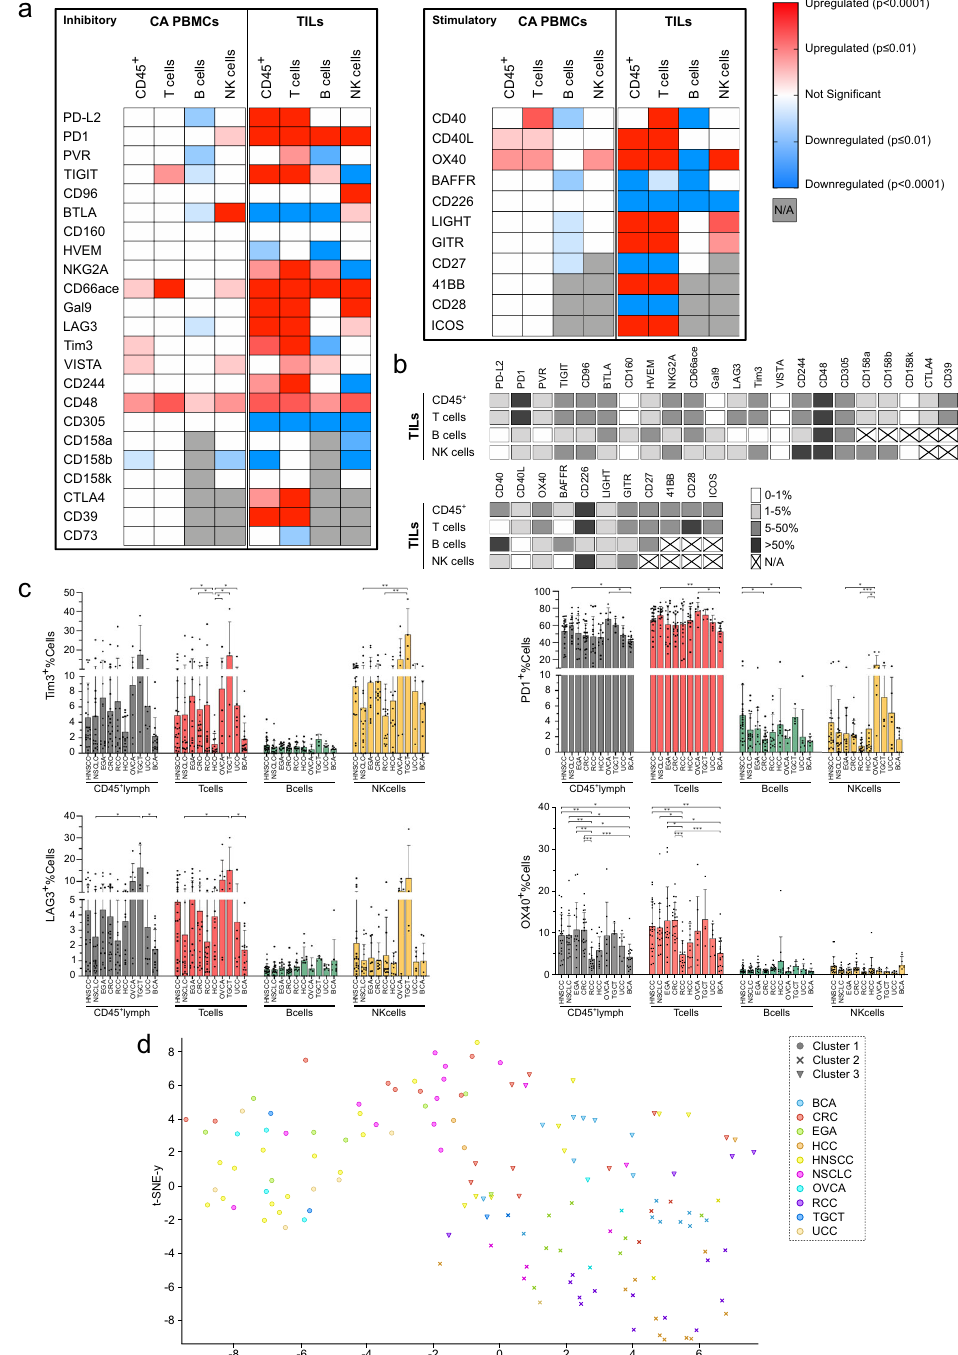
Fig. 2 Immune checkpoints on TILs are dysregulated with molecule and cancer-dependent differences. a Co-inhibitory and co-stimulatory molecule expression was analyzed by fl ow cytometry. The gating strategy is described in Supplementary Fig. 12. Signi fi cant up-/ downregulation of co-inhibitory and co-stimulatory immune-checkpoint molecule expression on CD45 + ( n = 137), T cells ( n = 137), B cells ( n = 120) and NK cells ( n = 118) of cancer PBMCs (CA PBMCs) and tumor-in fi ltrating lymphocytes (TILs) compared to the mean expression obtained from healthy control PBMCs (HC PBMCs, n = 20). b Categorical heatmap showing mean of absolute percentages of immune- checkpoint molecule expression on indicated lymphocyte subsets. c Cancer-dependent Tim3, PD1, LAG3, and OX40 expression on the indicated tumor-in fi ltrating lymphocyte was analyzed by fl ow cytometry. d t-SNE of immune subsets, phenotypes and immune-modulatory molecule expression across cancer types (using NKcells%CD45 + , Tregs%CD45 + and B cells%CD45 + , CD25 + %Tcells, Memory%Bcells, CTLA4 + % Tcells, ICOS + %Tcells, GITR + %Tcells). Clusters were assigned using Louvain community detection. Signi fi cant differences calculated by unpaired two-tailed Mann – Whitney test ( a ) and nonparametric Kruskal – Wallis test followed by Dunn ’ s post hoc test to correct for multiple comparisons ( c ) are indicated by asterisks. * p ≤ 0.05, ** p ≤ 0.01, *** p ≤ 0.001, **** p ≤ 0.0001. When appropriate, mean ± SD is